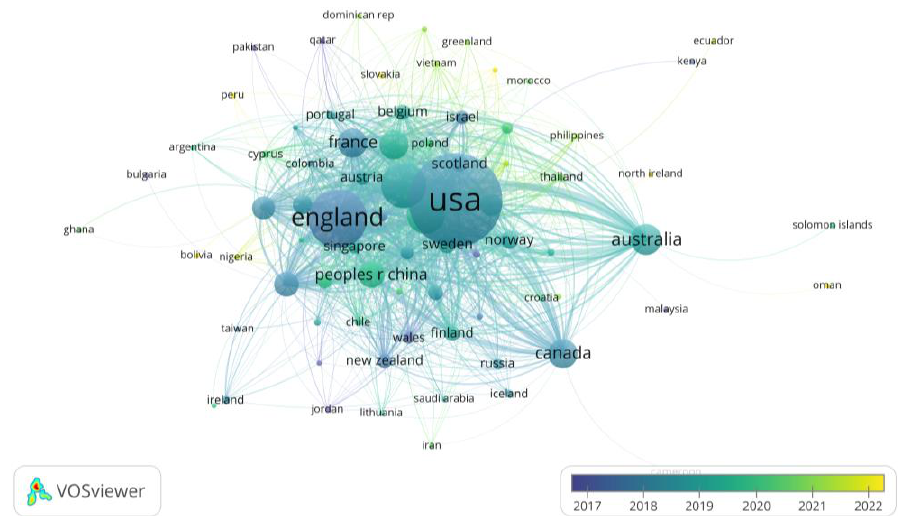
Figure 6. The overlay visualization of the country analysis. Table 5. Prominent authors by documents and